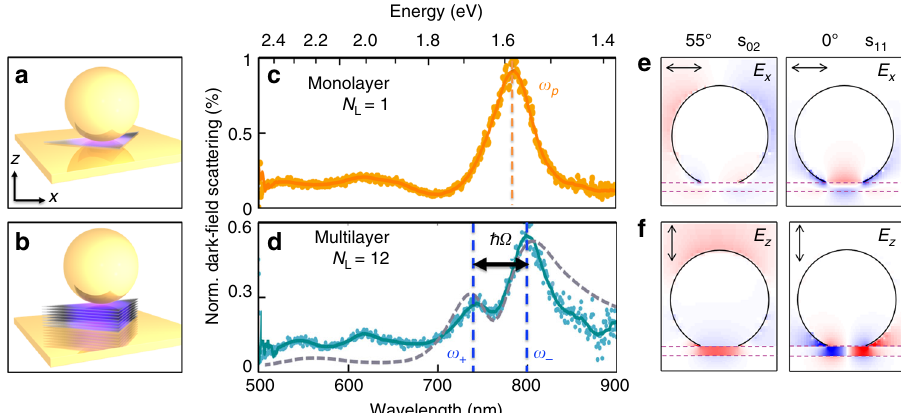
Fig. 1 Optical signature of single and multilayer WSe 2 embedded in plasmonic nanocavities. a , b Schematic of nanoparticle-on-mirror cavity encapsulating WSe 2 fl akes for N L = 1,12. c , d Dark- fi eld scattering of individual NPoMs showing single-plasmon peak for N L = 1 WSe 2 , but a mode splitting due to strong coupling for multilayer N L = 12 reproduced by FDTD simulations (dashed line). e , f Simulated fi eld distributions E x , z for two plasmon-coupled modes (s 02 , s 11 ) at λ = 780 nm with high refractive index material (dashed) in the 10 nm gap ( n = 2.8). Angles of incidence 55° (left) and 0° (right); red-blue colour-scale shows fi eld enhancements of ± 30 E 0 j